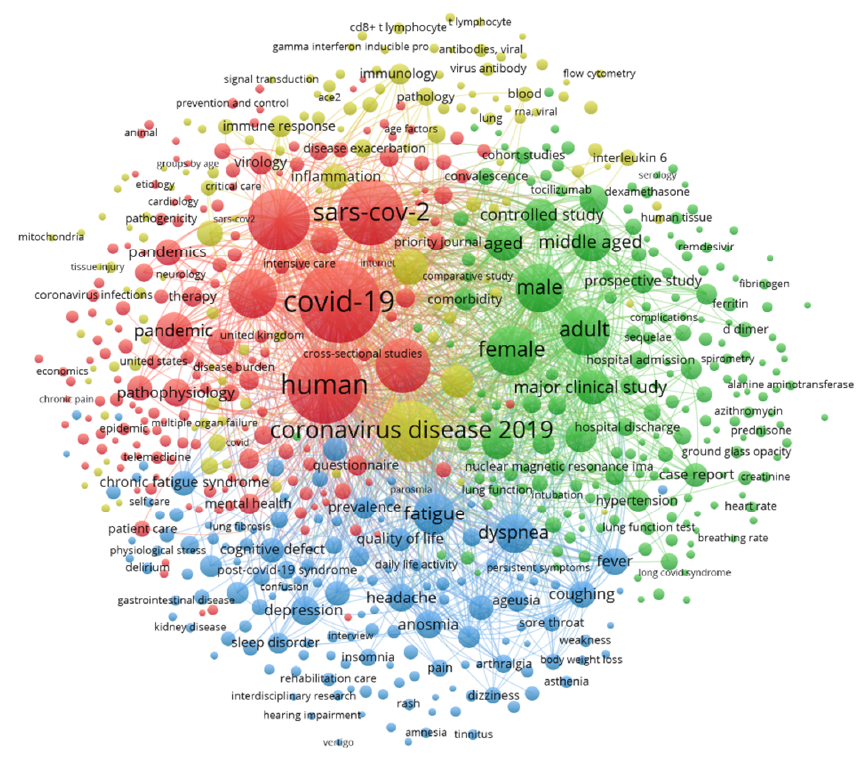
Figure 6. The keywords co-occurrence network. Red cluster: pathophysiology.